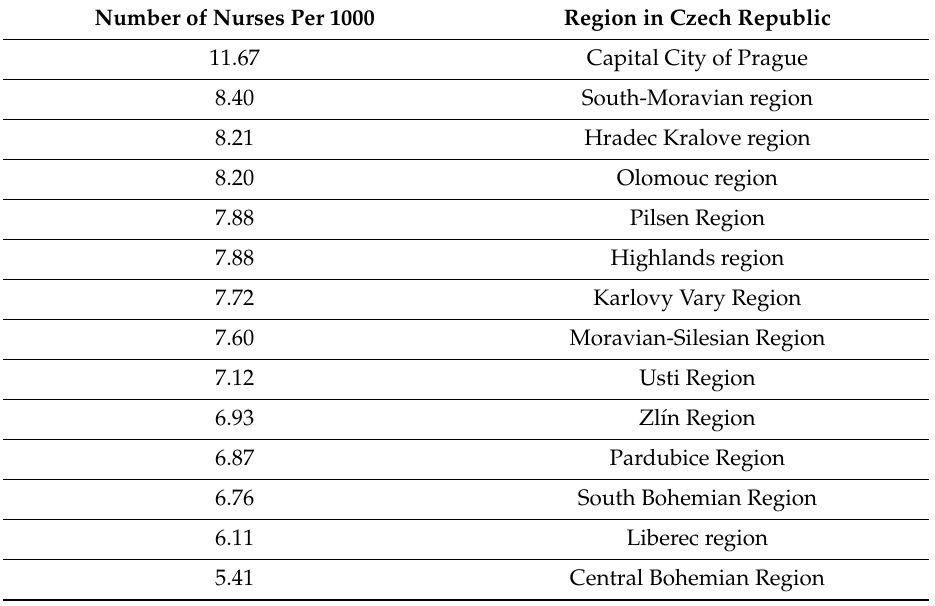
Table 1. Number of full-time equivalent nurses and midwives per 1000 population in all regions of the Czech Republic in